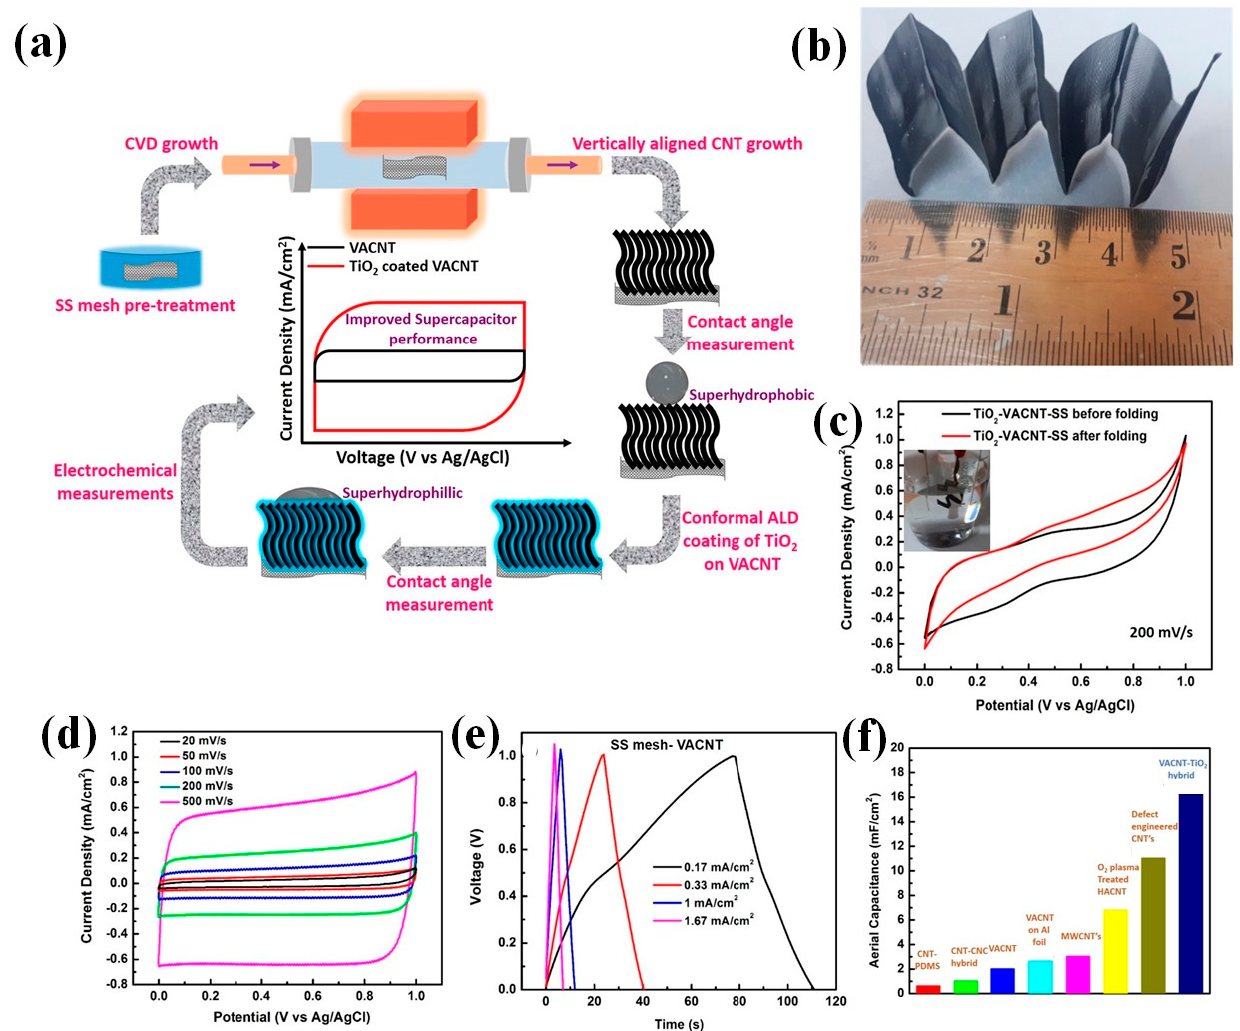
Figure 2. ( a ) Schematic illustration of the synthesis process, ( b ) photograph showing the flexible nature under mechanical deformation of as grown VACNT on SS mesh, ( c ) TiO 2 coated VACNT-SS mesh before and after zigzag folding showing negligible change in capacitance, ( d ) cyclic voltammograms for SS mesh-VACNT as a function of increasing scan rate showing nearly ideal EDL behavior, ( e ) galvanostatic charge − discharge curves for SS mesh-VACNT as a function of current densities ( f ) comparative specific capacitance values with earlier reported literature for carbon-based electrode materials showing improved performance. Reproduced from Ref. [77]. Copyrights (ACS, 2019).